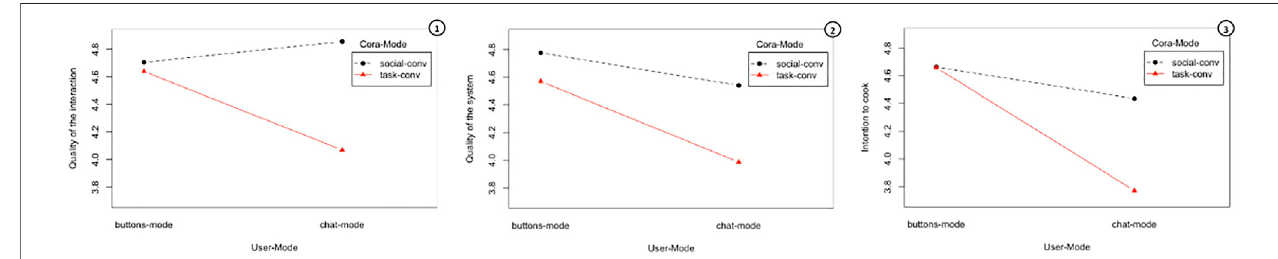
FIGURE3| InteractiongraphsbetweenCora-ModeandUser-Moderegardingtheaveragescoresforalltheitemsrelatedtothequalityoftheinteraction,thequality of the system and users intention to cook.